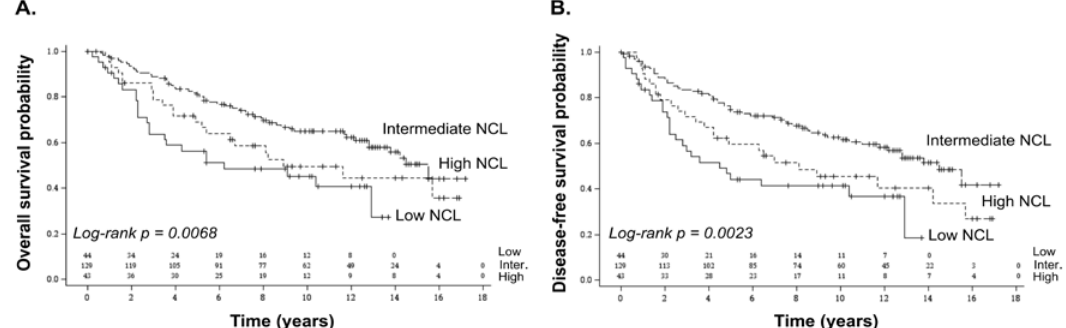
Figure 1. Association of NCL expression levels with poor prognosis in breast cancer using Dundee series. A significant association was observed between NCL expression levels and overall ( A ) as well as disease-free survivals ( B ). Association between NCL expression levels and survival was analysed using Kaplan–Meier representation. Number of subjects at risk is indicated on the graph for the three NCL groups (low; intermediate; high). Log-rank p -value ≤ 0.05 was used to determine significant association. When compared to 11 healthy mammary tissues, NCL mRNA expression levels of the healthy donors were not significantly different from the low NCL -expressing group, while they were expression levels corresponded to NCL overexpression compared to normal tissues (Figure